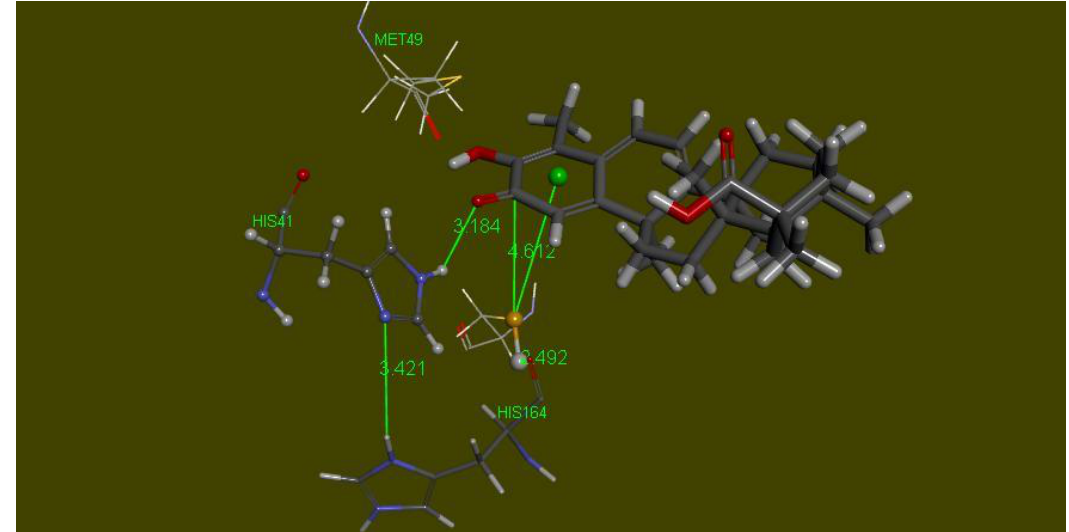
Figure 13. Docking pose 5 displays the essential amino acids, Cys145 (line style, not labeled for clarity), His41 (ball style), Met49 (line style), and His164 (stick style). S(Cys145) points to the quinoid ring centroid, 4.989 Å (value not shown for clarity), and the quinoid carbonyl, 4.612 Å. Met149 is rather detached from ring B centroid.